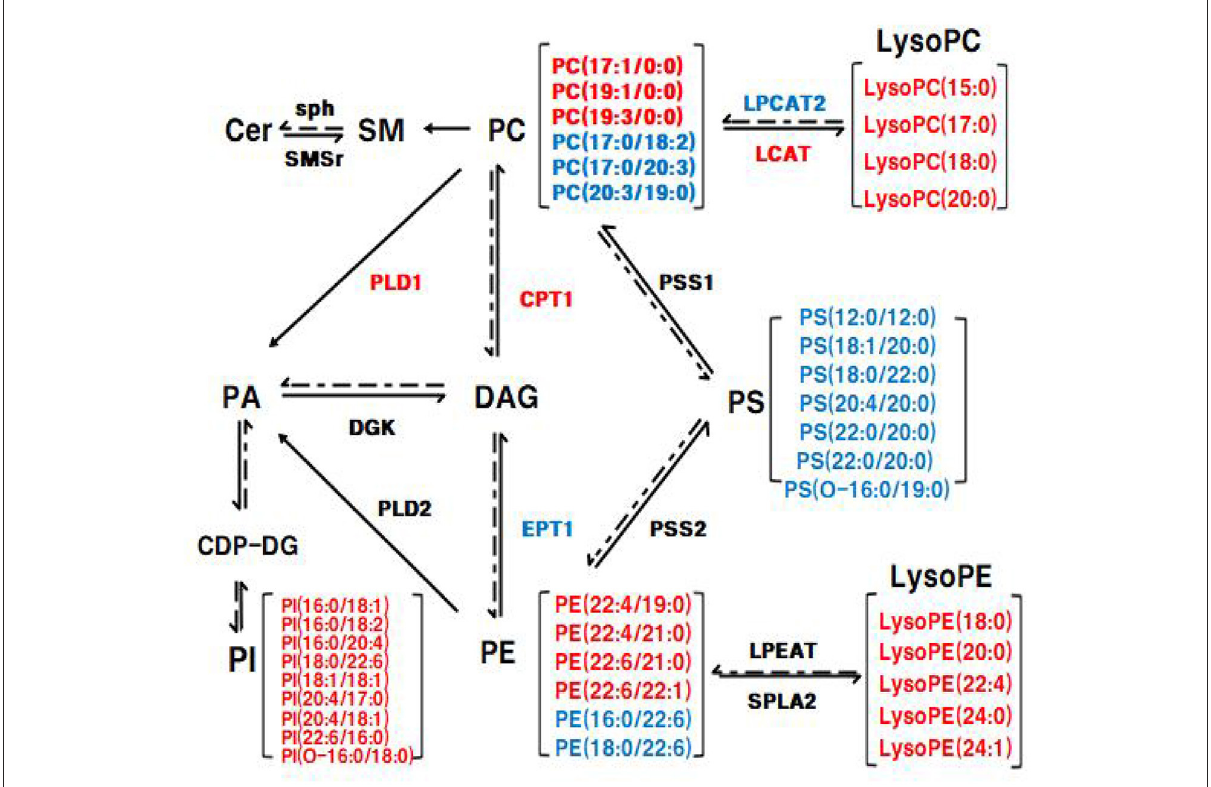
FIGURE10 The Glycerophospholipid metabolism and sphingolipid metabolism in liver. The mRNA expression of genes in red was up-regulated and the mRNA expression of genes in blue was down-regulated in eWAT, respectively; the lipid level in red was up-regulated and the lipid level in blue was down-regulated in eWAT,